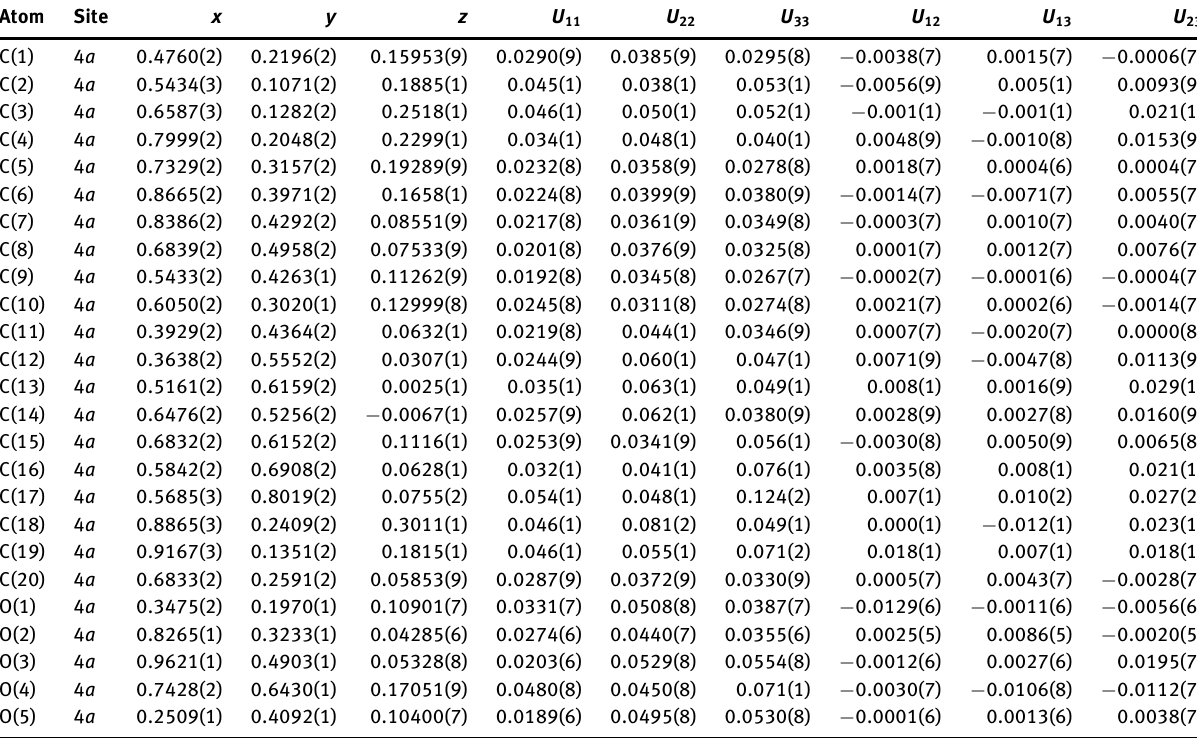
Table 3: Fractional coordinates and atomic displacement parameters (Å 2